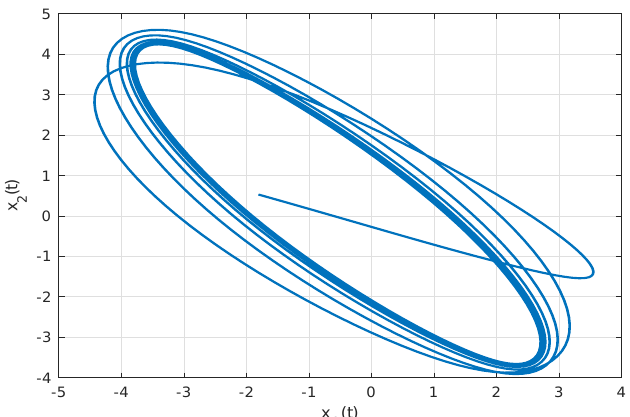
Figure 1. Phase plane of INNs (20) without any control input.